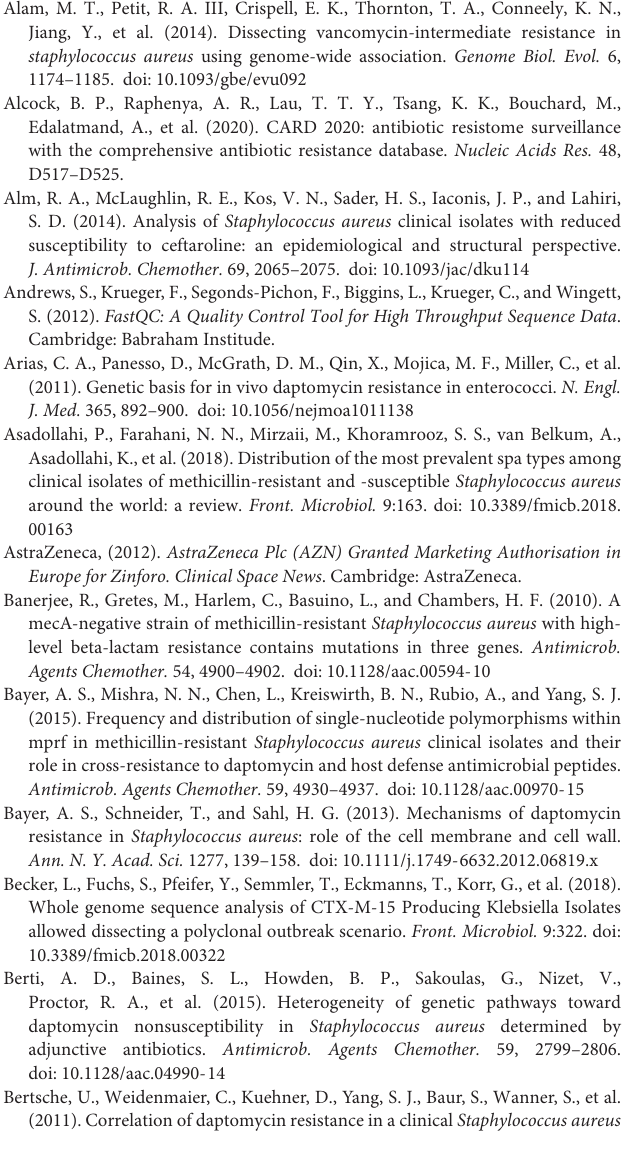
Supplementary Table 1 | Details on the daptomycin strain collection. Supplementary Table 2 | Details on the ceftaroline strain collection.